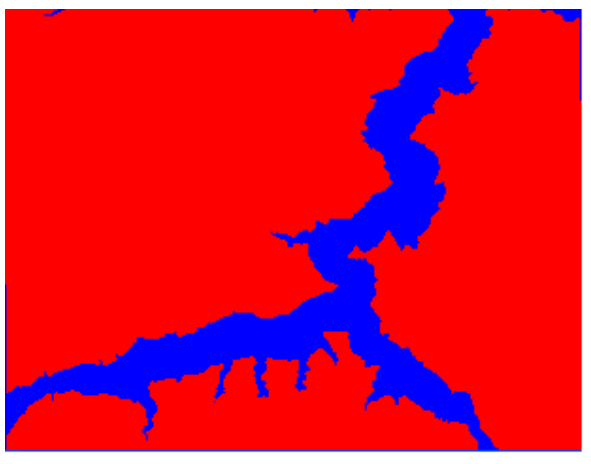
Figure 19. Forecast result of K—Means